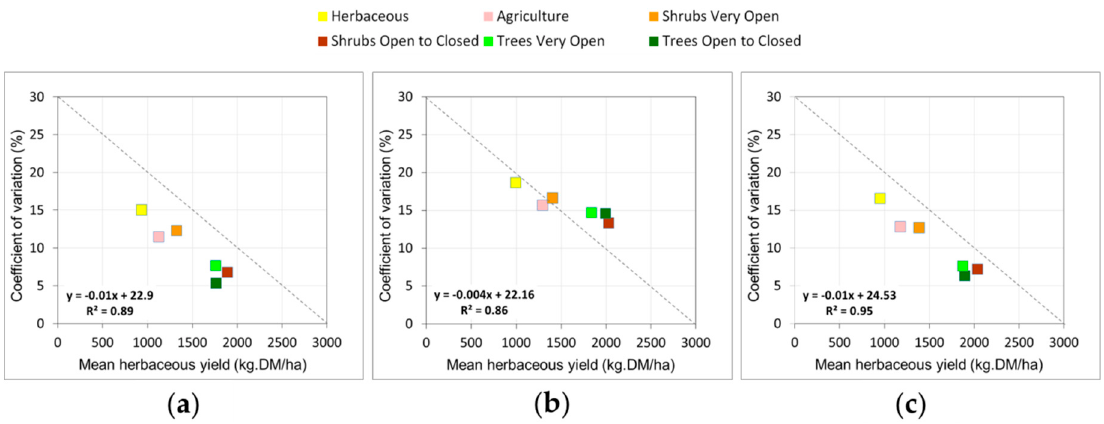
Figure 8. Coefficients of variation in annual herbaceous yield estimated by the three models: ( a ) VI-model; ( b ) AGRO-model; ( c ) VIAGRO-model, according to the 2000–2015 average.